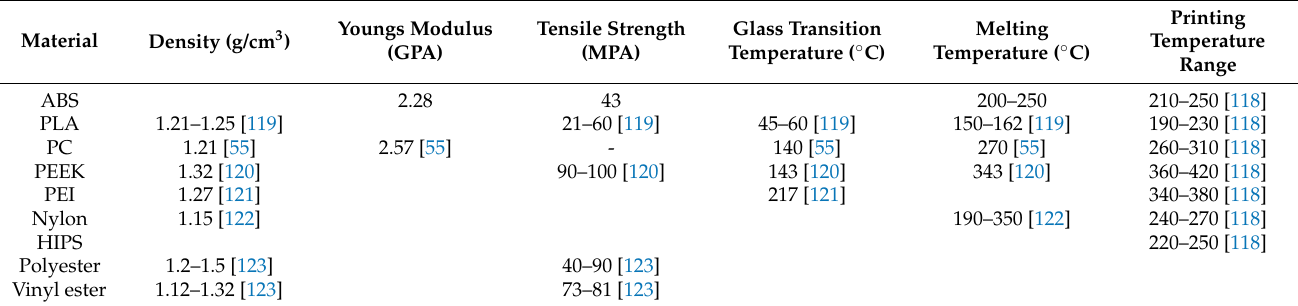
Table 3. Thermo-mechanical properties of various materials used in